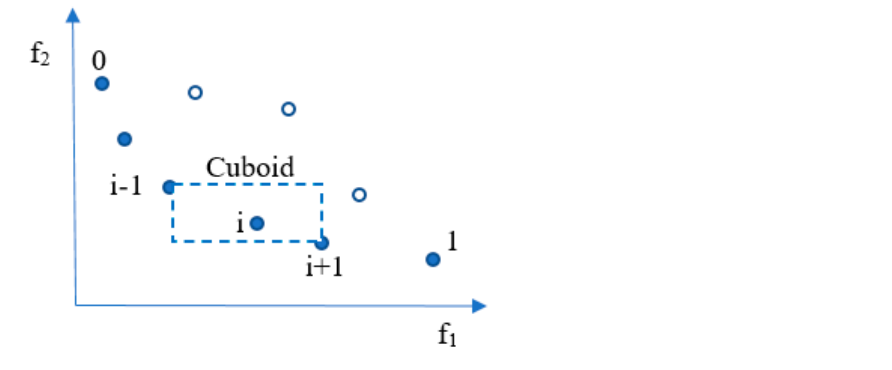
Figure 8. The concept of swarm distance for point i .